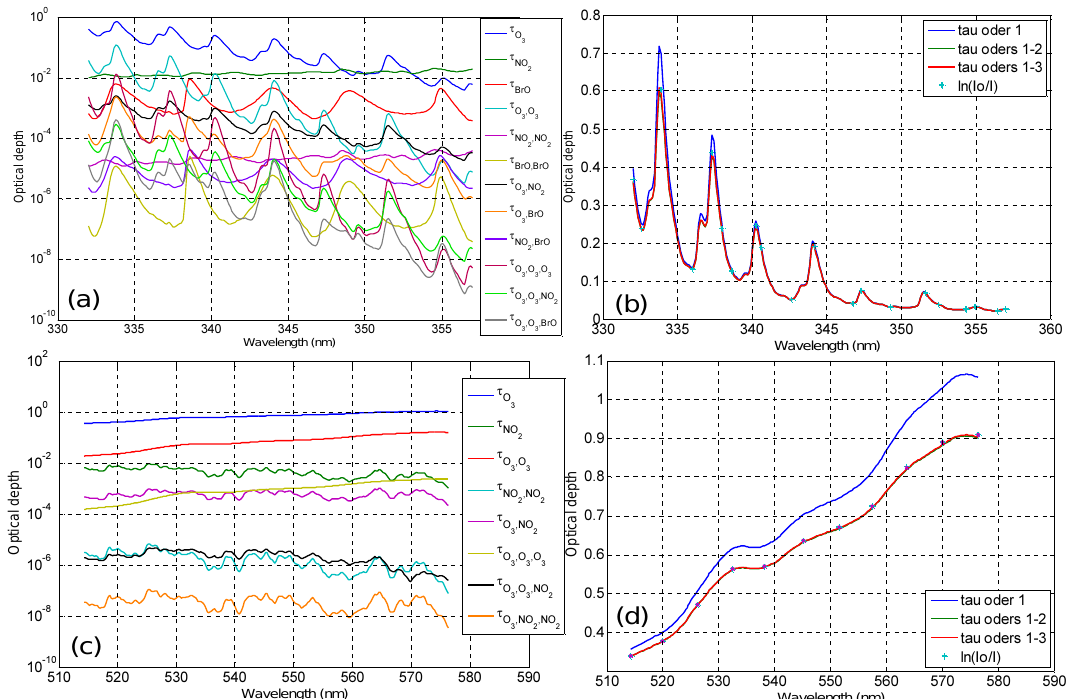
Figure 2. (a) Contribution (absolute values) to the OD by different Taylor series terms in the UV spectral region with three absorbers (ozone, NO 2 , and BrO) for a simulated scenario characteristic for SCIAMACHY limb observations at high northern latitudes in March (TH = 19.83km). All OD terms up to the second-order and the largest third-order terms are shown. (b) Simulated (true) absorption OD in comparison with the OD calculated from the effective light paths considering absorption up to a certain order. (c, d) Same as (a) and (b) but in the visible spectral range with two absorbers (ozone and NO 2 ).